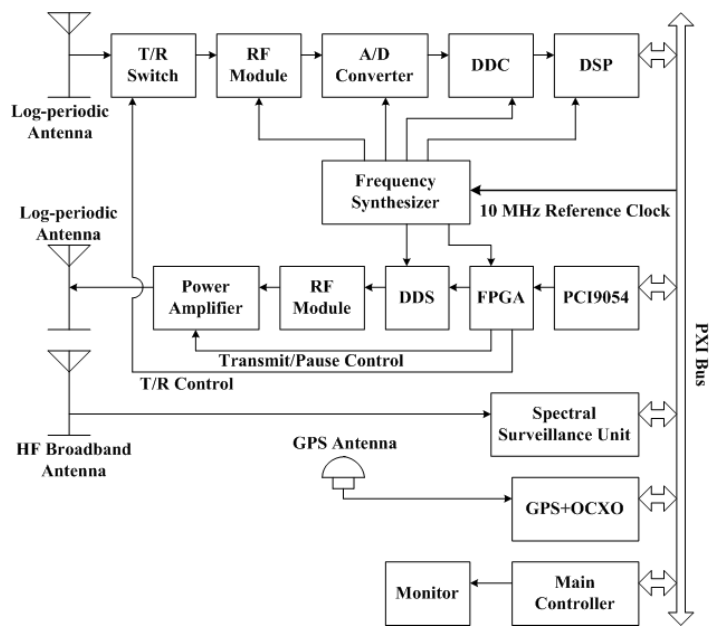
Figure 2. Block diagram of the third version of WIOBSS. GPS: Global Positioning System; HF: high-frequency; OCXO: oven-controlled crystal oscillator; PXI: Peripheral component interconnect eXtensions for Instruments.